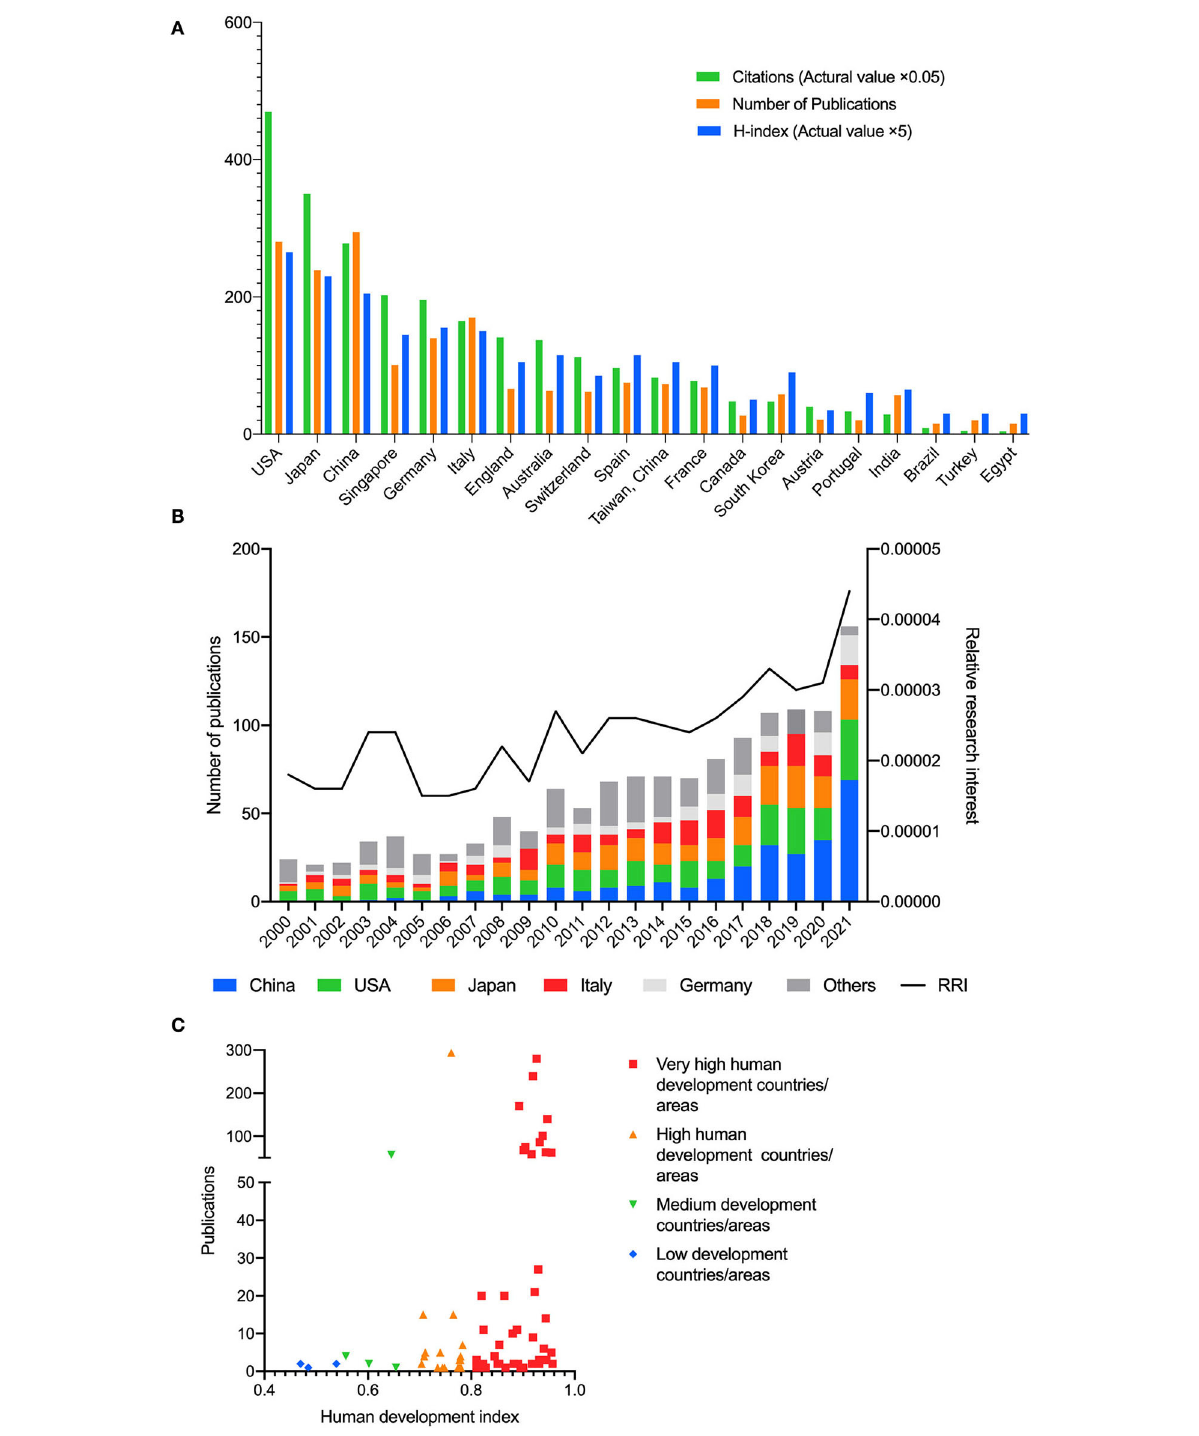
FIGURE1 (A) Top 20 countries/regions in the publications on pathologic myopia. The green bar shows the number of citations (actual value multiply by 0.05), the orange bar shows the number of publications, and the blue bar shows the H-index (actual value multiply by 5). (B) The proportion of publications of China Mainland, USA, Japan, Italy, Germany, and other countries/regions and relative research interest (RRI) in each year on the field of pathologic myopia. (C) The number of publications on pathologic myopia in countries or areas of various levels of human development. Very high human development countries or areas contributed to most